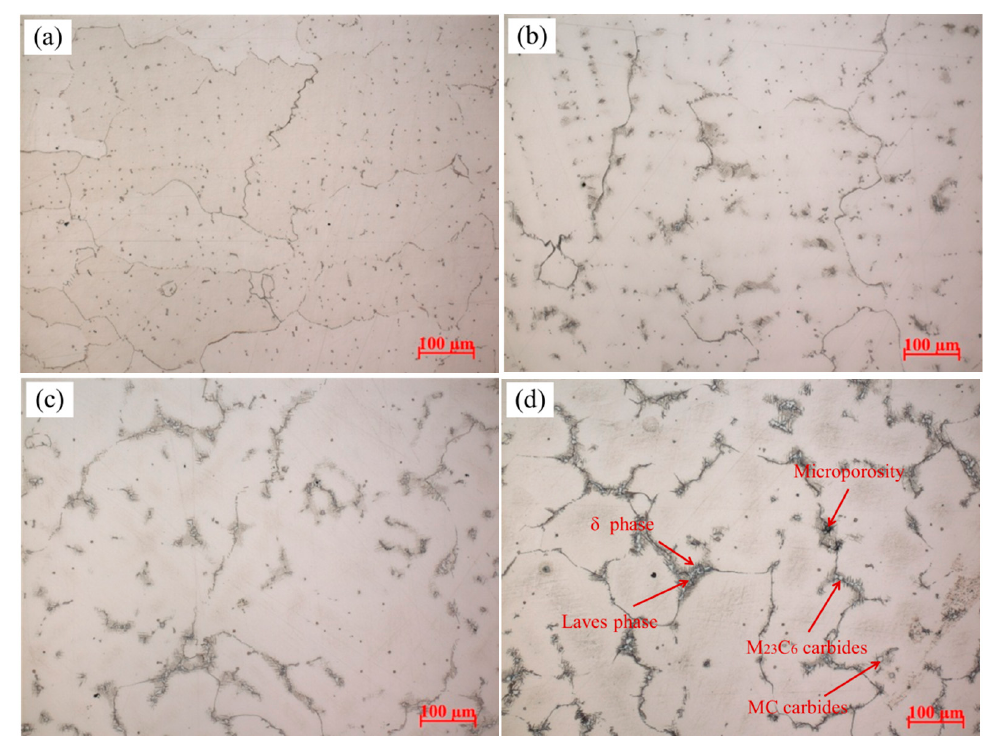
Figure 5. Optical microstructures of the superalloy casting ( a ) 3 mm; ( b ) 6 mm; ( c ) 12 mm; and ( d ) 24 mm.